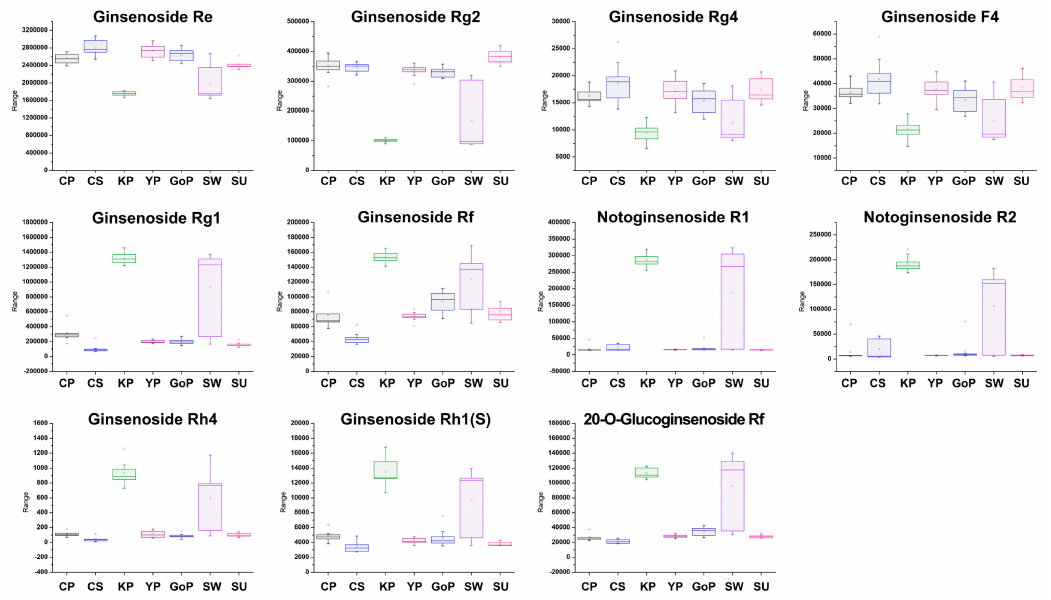
Figure 8. Box plots of protopanaxatriol (PPT)-type ginsenosides which showed characteristic patterns in the Kumpoong (KP) and Sunwon (SW)